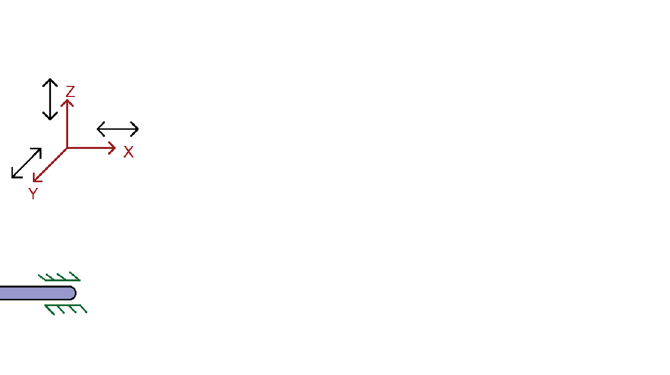
Figure 7. A complete representation of automated graphite pencil holder orientation (motion) with graphtec